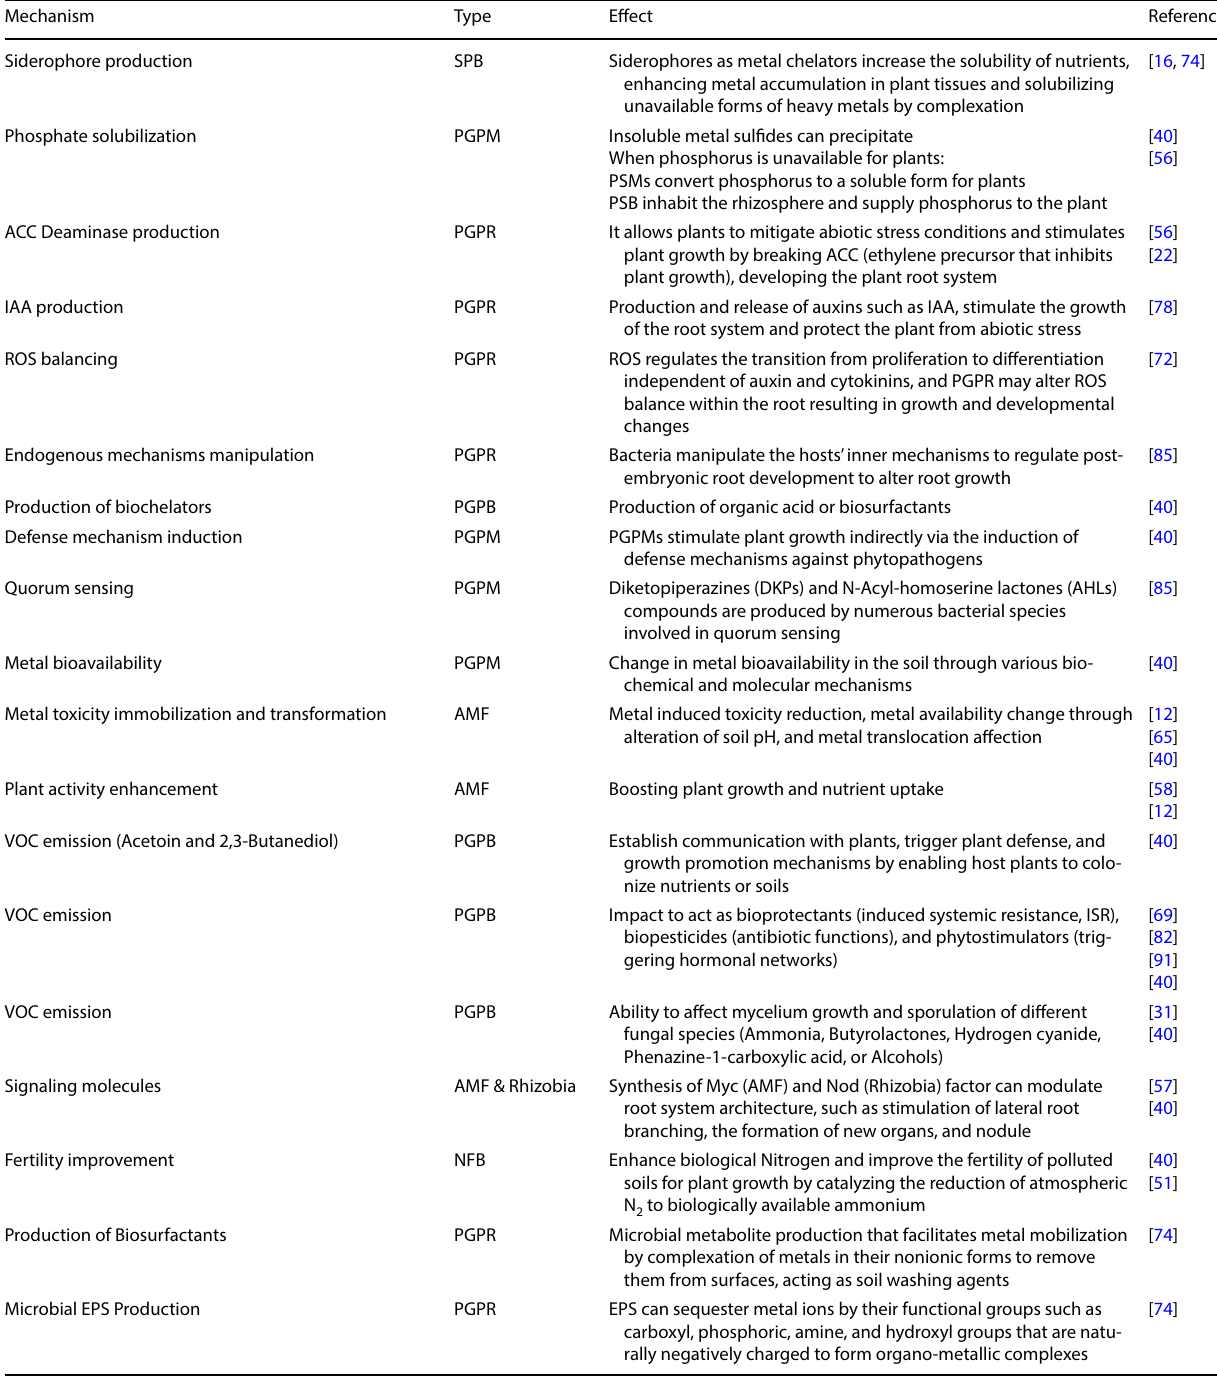
Table 5 Role of PGPMs in plant growth and